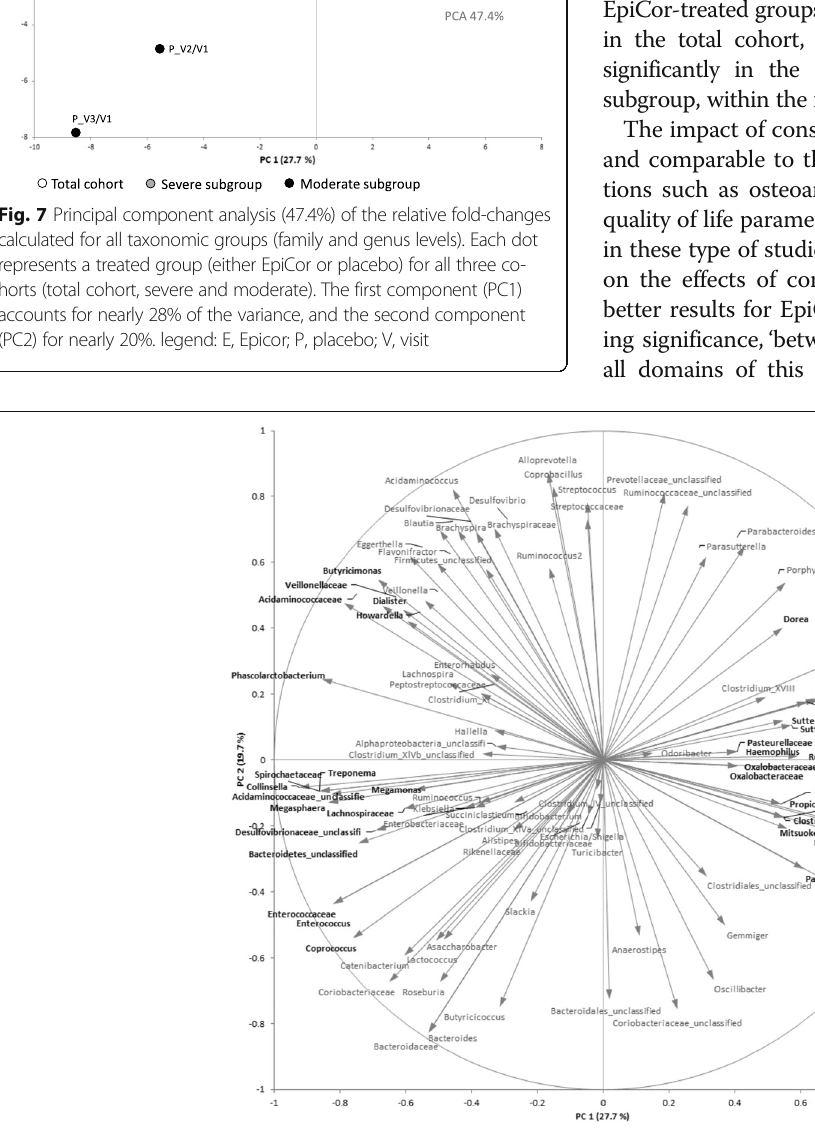
Fig. 8 Variables (taxa) correlation plot. Each vector represents a taxonomic group (family or genus levels). Shorter vectors only slightly contribute for differentiation between groups. Longer vectors have a bigger weight in groups ’ differentiation. Those variables that mostly contribute the first component (PC1) are indicated in bold